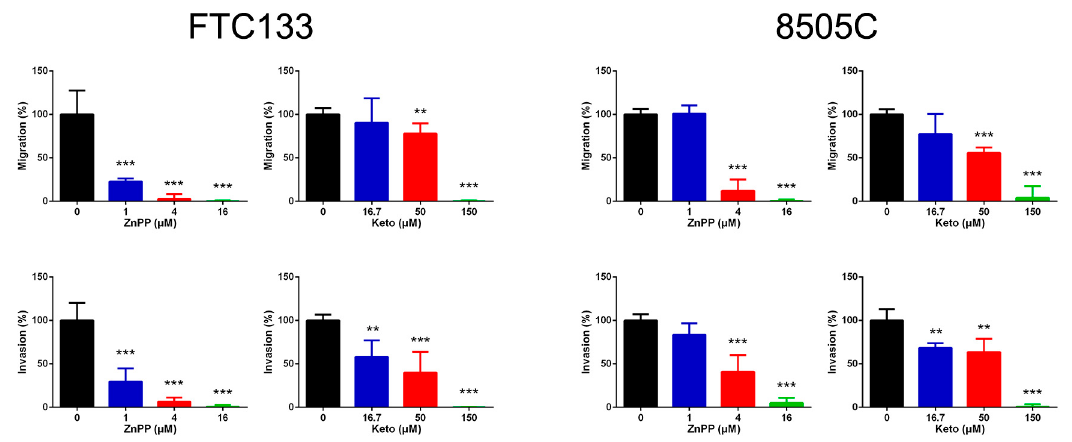
Figure 4. Cellular migration and invasion suppressed by heme oxygenase-1 inhibitors, zinc protoporphyrin-IX (ZnPP) and ketoconazole (Keto), in thyroid cancer cells. ** p < 0.01 versus control, *** p <